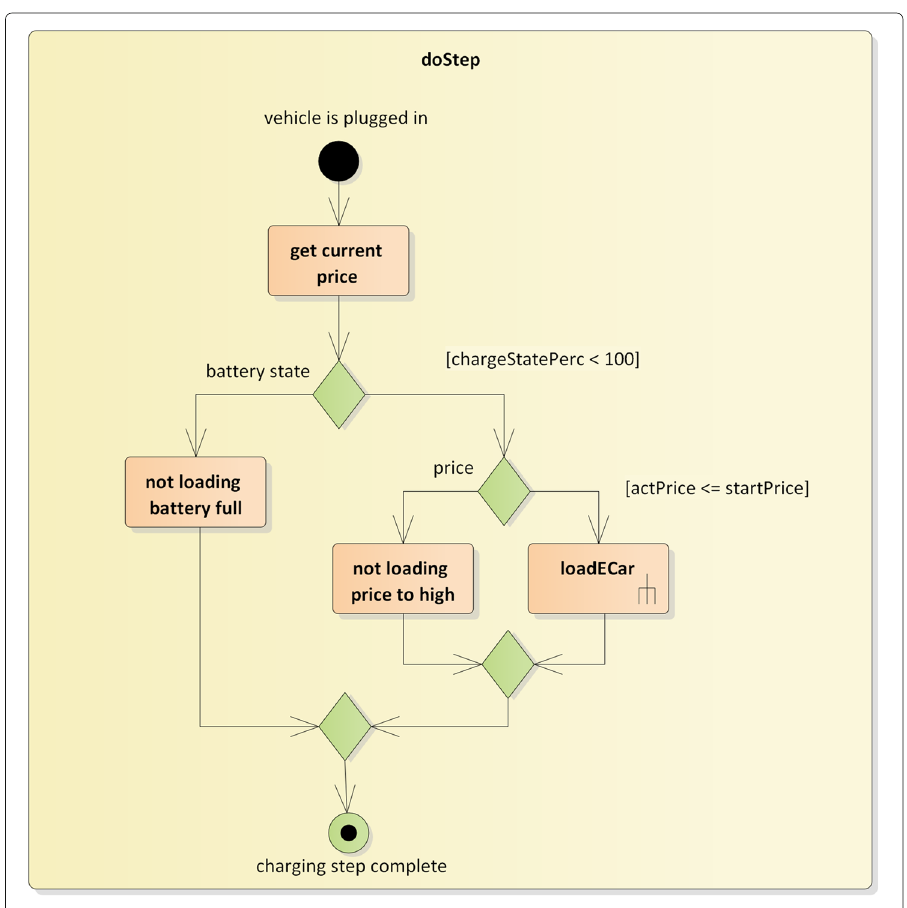
Fig. 5 Activity diagram of EV charging behavior